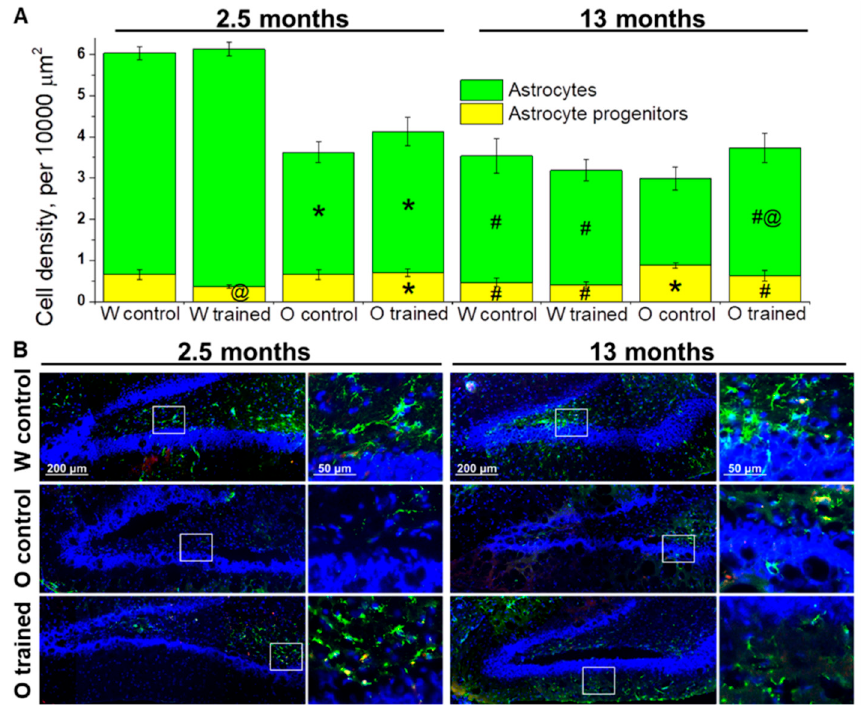
Figure 4. Density of cells of the astrocyte lineage in the DG of OXYS and Wistar rats. ( A ) At age 2.5 months, the density of astrocytes was lower in OXYS rats than in Wistar rats; training in the MWM resulted in faster maturation of astrocyte progenitors in Wistar rats. At 13 months of age, the density of astrocyte progenitors was higher in OXYS rats compared to Wistar rats, and the MWM training increased astrocytes’ density in OXYS rats. The data are presented as mean ± SEM, n = 3 to 6. * p < 0.05 for differences between the strains; # p < 0.05 for a comparison with the previous age; @ p < 0.05 for effects of the MWM training. W: Wistar rats; O: OXYS rats. ( B ) Photomicrographs of the DG of control Wistar and OXYS rats, as well as trained OXYS rats at ages 2.5 and 13 months are shown as representative images of immunohistochemical staining with antibodies against glial fibrillary acid protein (GFAP; green) and vimentin (red). DAPI (blue) highlights cell nuclei. The density of astrocytes was influenced by genotype (F 1.64 = 43.7, p < 0.0001) and age (F 1.64 =